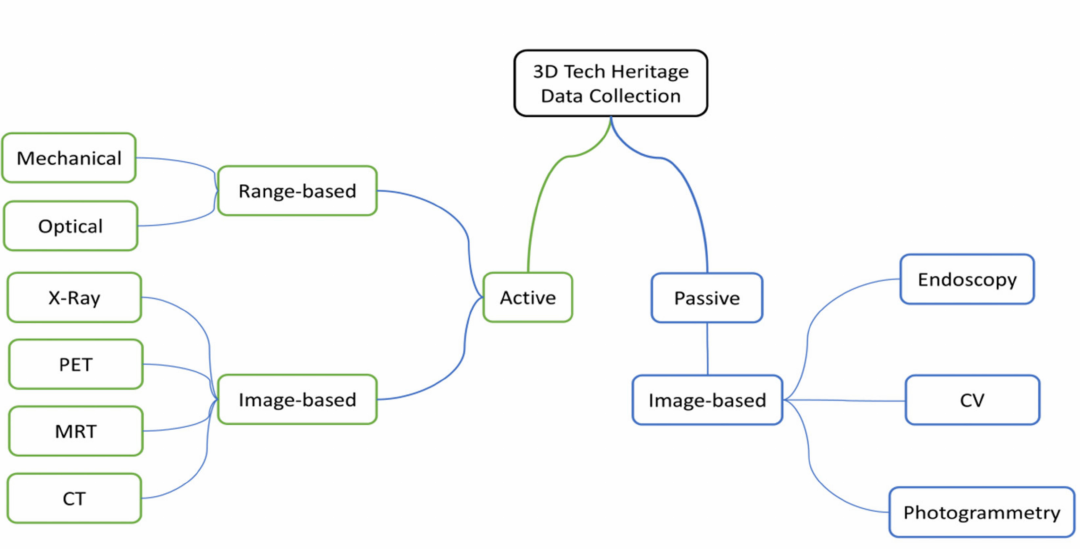
Figure 1. Taxonomy for 3D tech heritage data